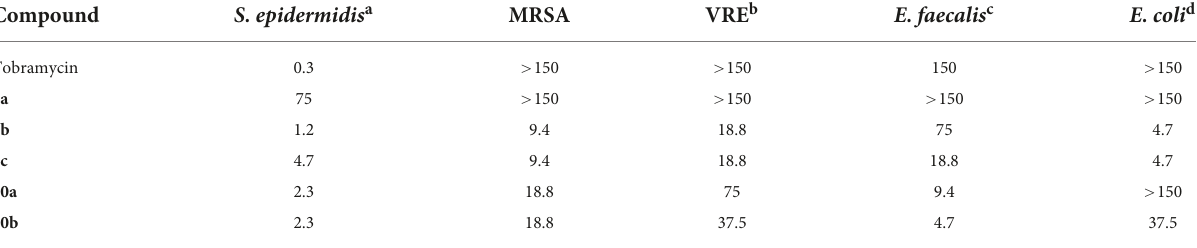
TABLE 3 MICs of 6"-modified amphiphilic tobramycin derivatives (in µ g/mL) (Herzog et al., 2012). Compound